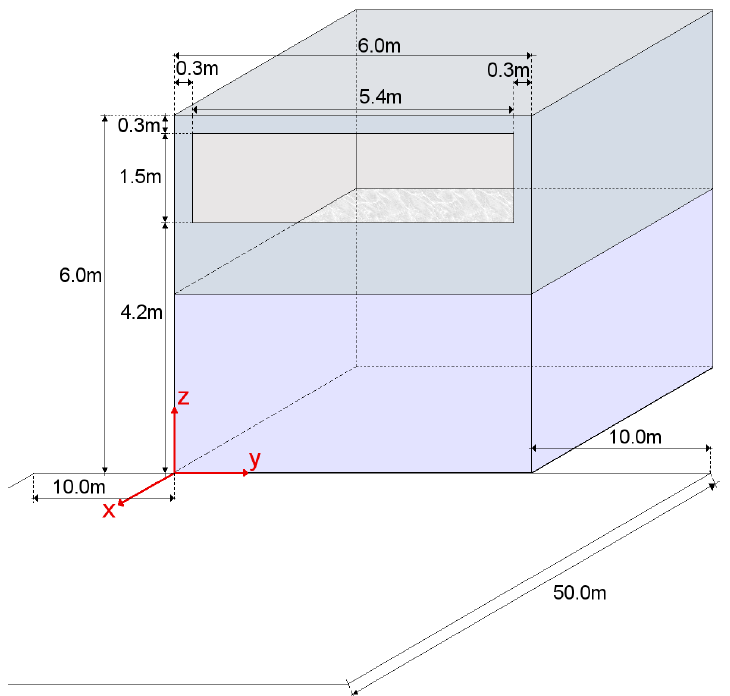
Figure 11. Simulation configuration. In the scenario, the emitters are located in a room 6 m wide